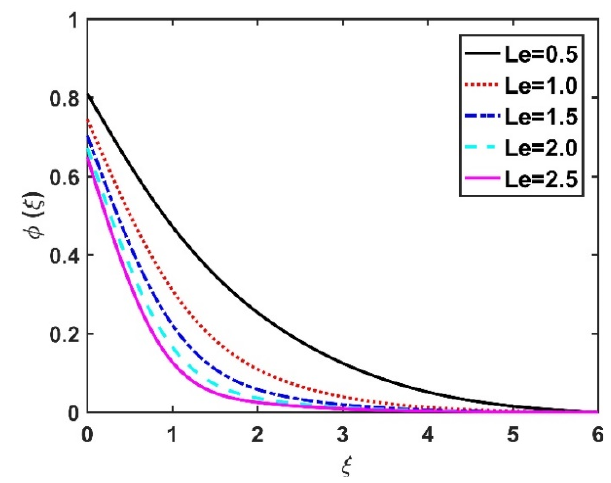
Figure 21. Impact of 𝐿𝑒 on 𝜙(cid:4666)𝜉(cid:4667) .